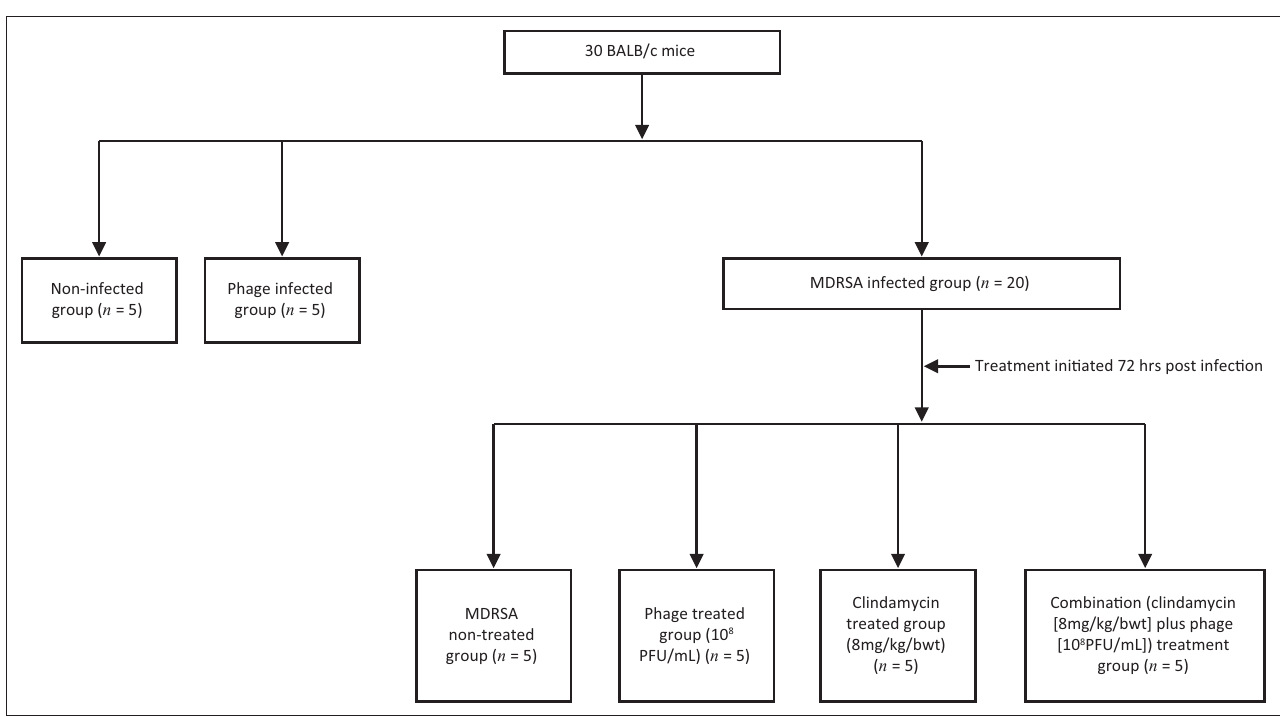
FIGURE 1: Design of the in vivo experimental study. The study was repeated three times and a total number of 90 mice were